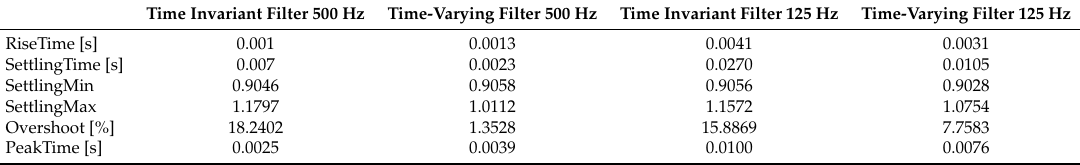
Table 2. Step response characteristics parameters comparison of the time invariant and time- varying systems.